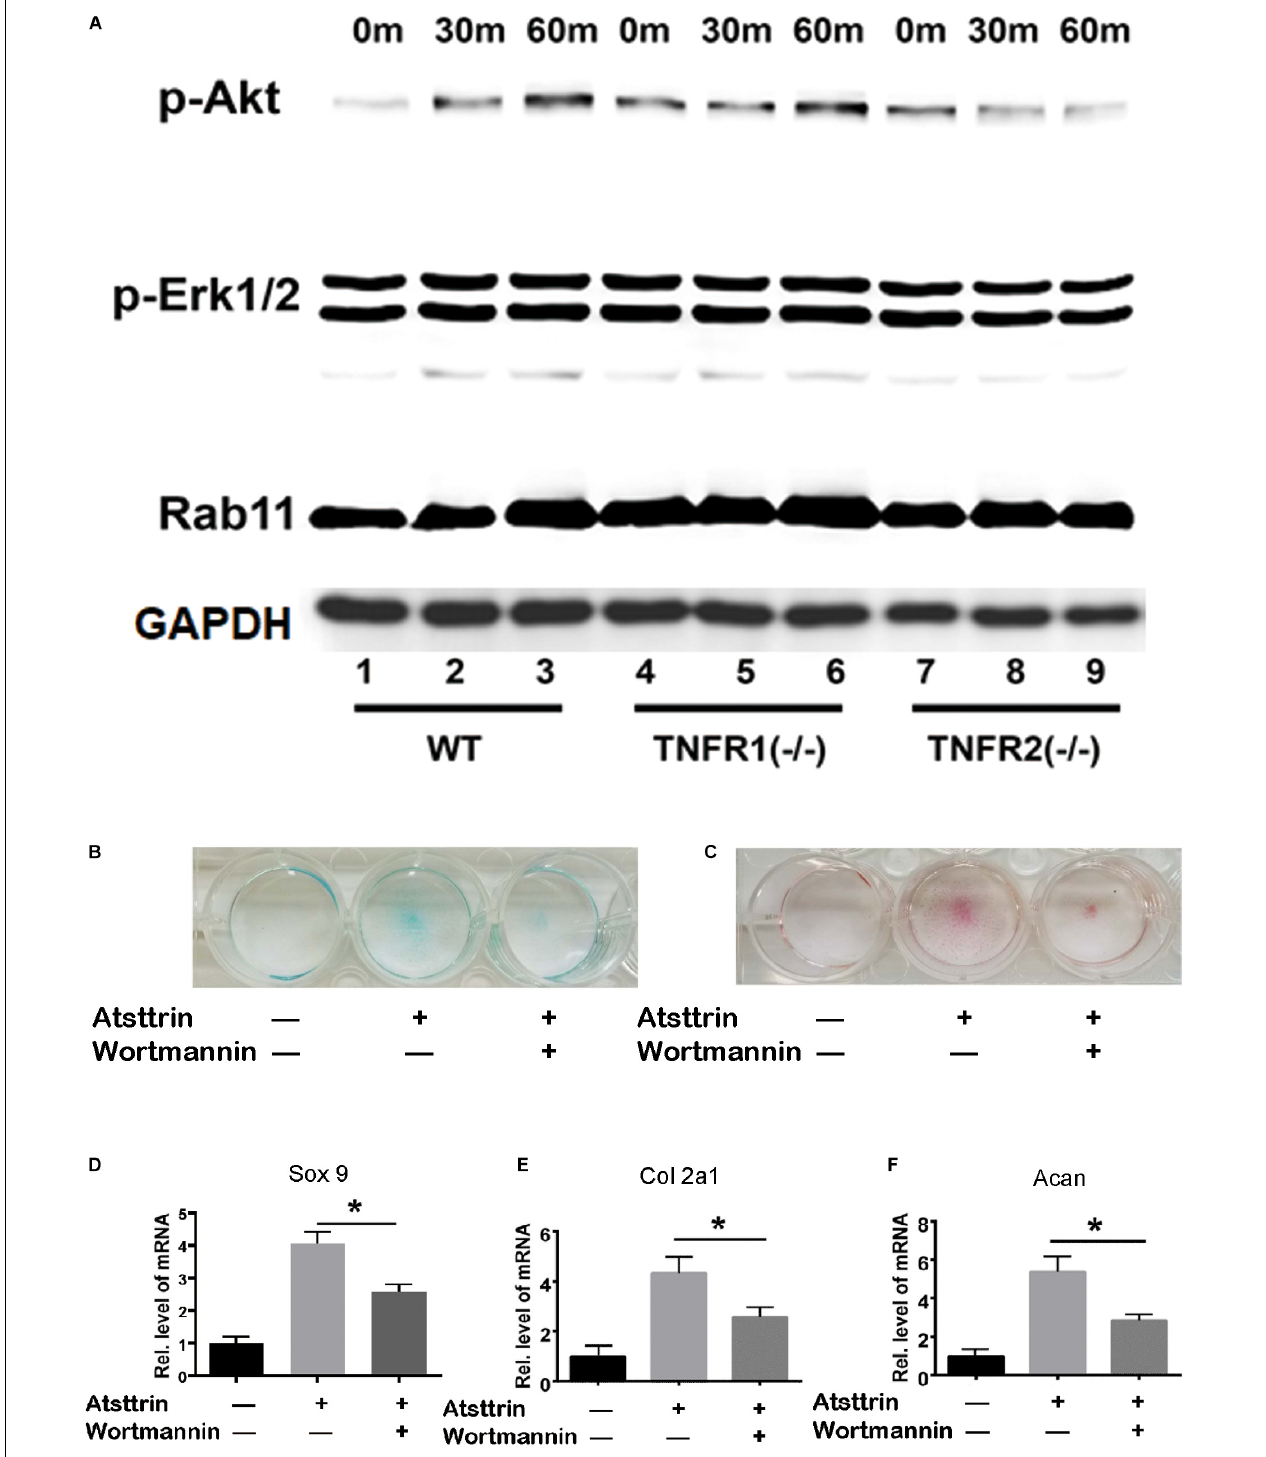
FIGURE 4 | Atsttrin-mediated chondrogenesis depended on TNFR2-Akt signaling. (A) Primary bone marrow stem cells were isolated from WT, TNFR1–/–, and TNFR2–/– mice, cultured in the presence of 1000 ng/mL Atsttrin, and collected at various time points, followed by Western blot analysis using PathScan Multiplex Western Cocktail I. (B,C) BMSCs were incubated in the absence (CTR) or presence of 1000 ng/mL Atsttrin with or without 1 µ M Wortmannin for 10 days, followed by Alcian blue staining and safranin O staining. (D–F) BMSCs were incubated in the absence (CTR) or presence of 1000 ng/mL Atsttrin with or without 1 µ M Wortmannin, and the expression of Sox9, collagen II (Col2a1), and aggrecan (Acan) was measured using real-time PCR. Values were normalized to controls, here given the value of 1. Three independent experiments were performed. * P < 0.05.